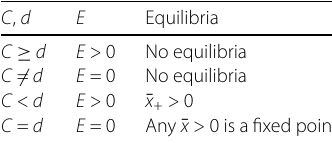
Table 5 Existence of equilibria for a = 0, f =